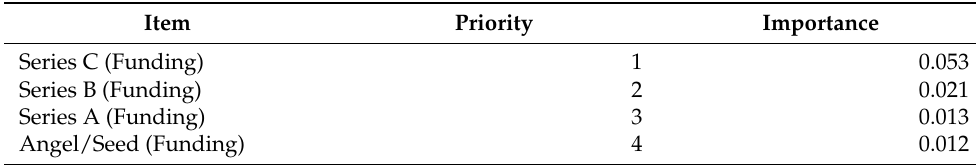
Table 6. Results of funding